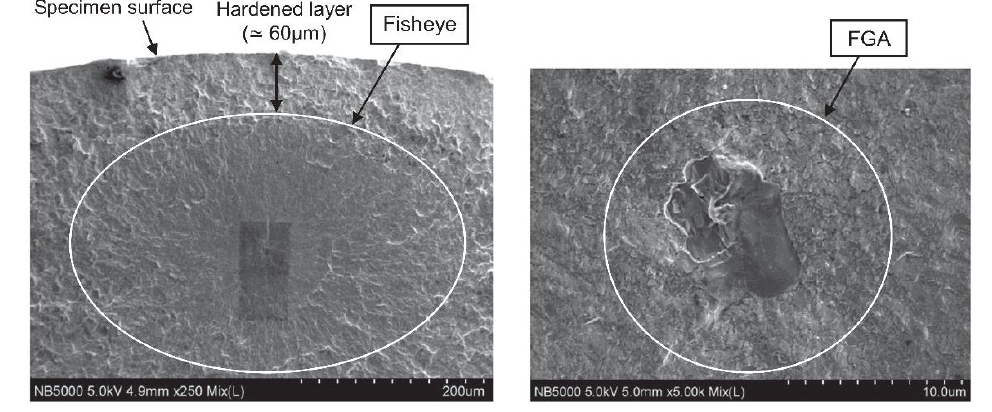
Figure 10. SEM observations of the fracture surface of the interior inclusion-induced fracture from rolling-treated JIS SUJ2 specimens: ( a ) fisheye formed on the fracture surface; ( b ) inclusion and FGA at the crack initiation site. Reprinted with permission from Ref. [4]. Copyright 2015 Wiley.